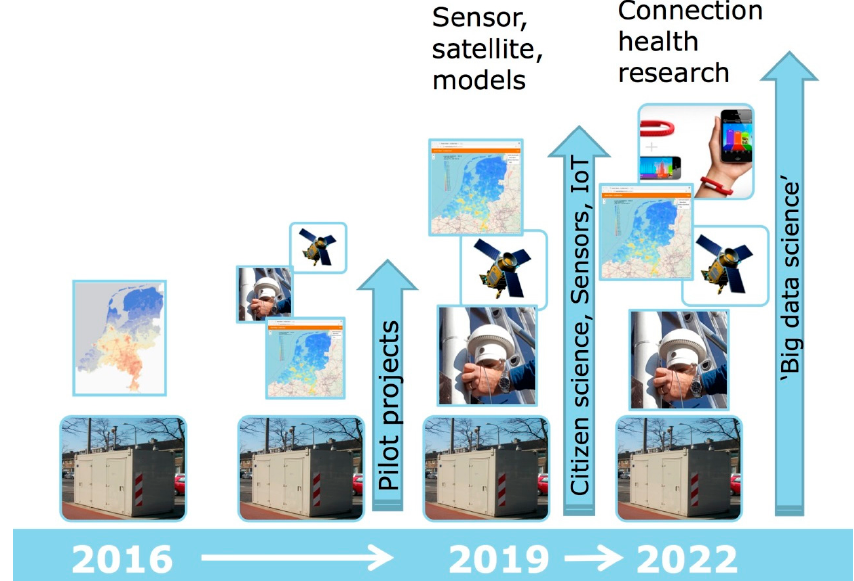
Figure 1. Roadmap of the Dutch Innovation Program for Environmental Monitoring (IPEM) and its associated milestones.